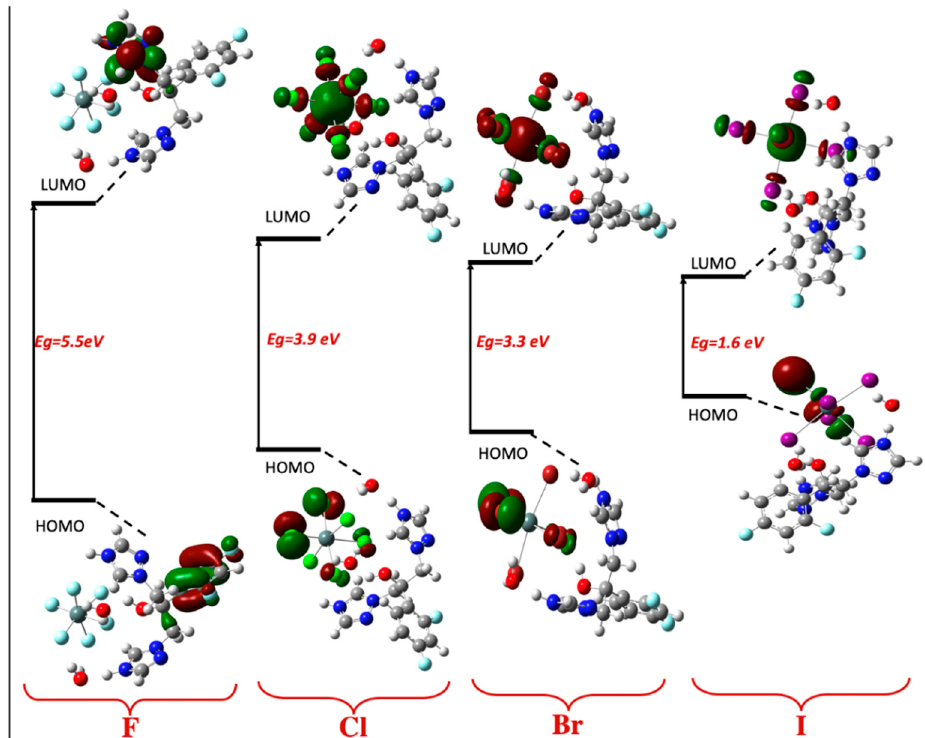
Figure 13. Frontier molecular orbitals and energy gap (Eg in eV) of (H2Fluconazole).SnX 6 .2H 2 O; (X = F, Cl, Br and I).